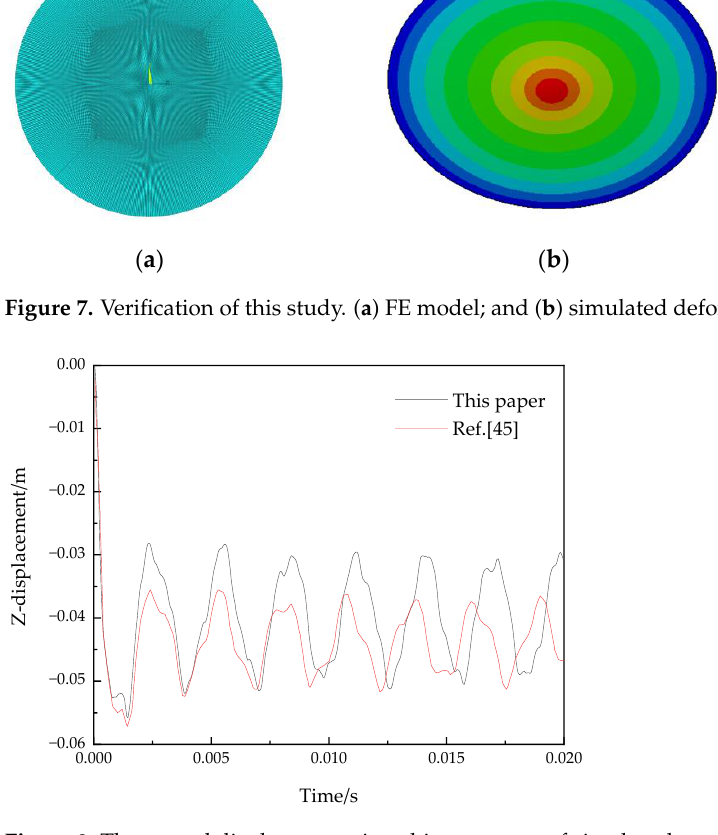
Table 5. Comparison of center deflection results.